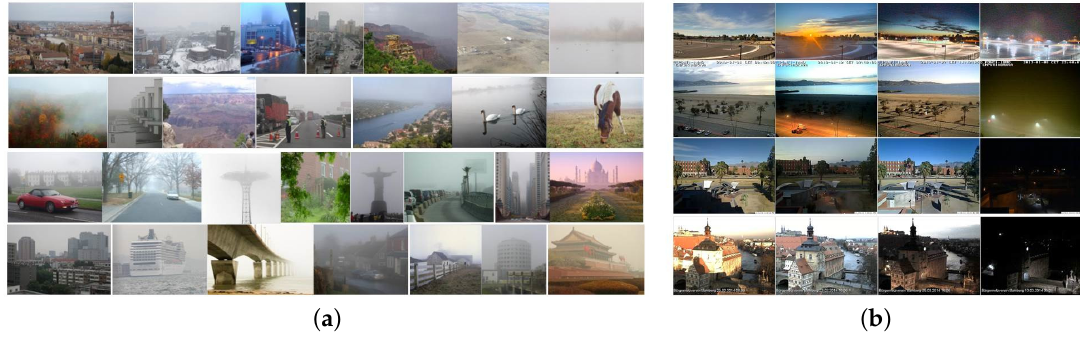
Figure 1. Sample images from ( a ) the HazySky dataset, and ( b ) the SkyFinder